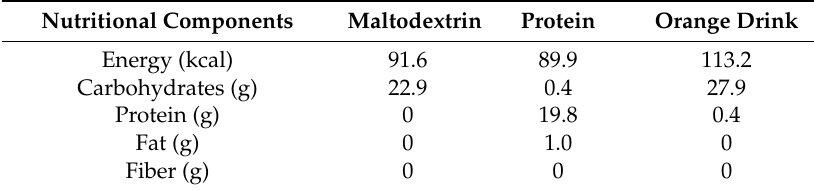
Table 1. Nutrient composition of supplements and orange drink. Nutritional